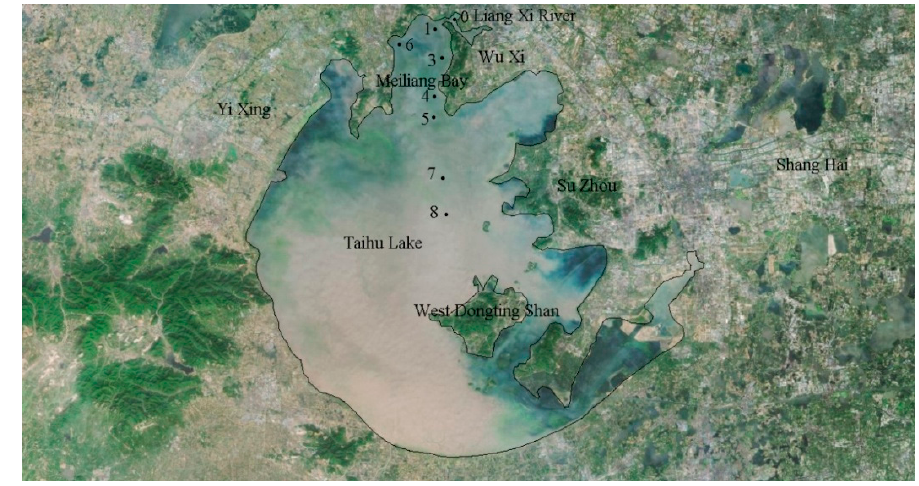
Figure 1. Locations of the sites in Taihu Lake.